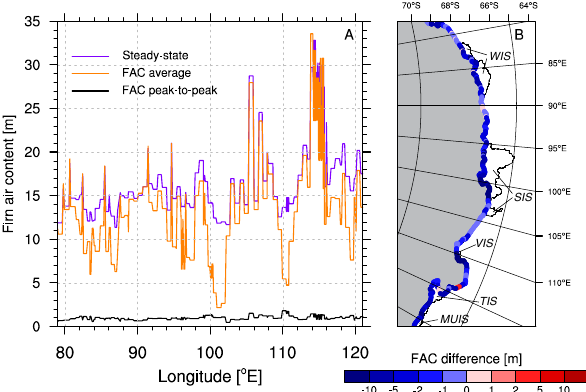
Figure 4. Firn air content (FAC) along part of the grounding line in East Antarctica (78–122 ◦ E, projected as (a) a function of longitude ( ◦ E), and (b) as a map. In (a) , the FAC from the steady-state (pur- ple) and time-dependent (orange) models, as well as the peak-to- peak difference (black) in the time-dependent model, are shown. In (b) , the average difference between both models is shown. Names of ice shelves: West Ice Shelf (WIS), Shackleton Ice Shelf (SIS), Vin- cennes Ice Shelf (VIS), Totten Ice Shelf (TIS), and Moscow Uni- versity Ice Shelf (MUIS).